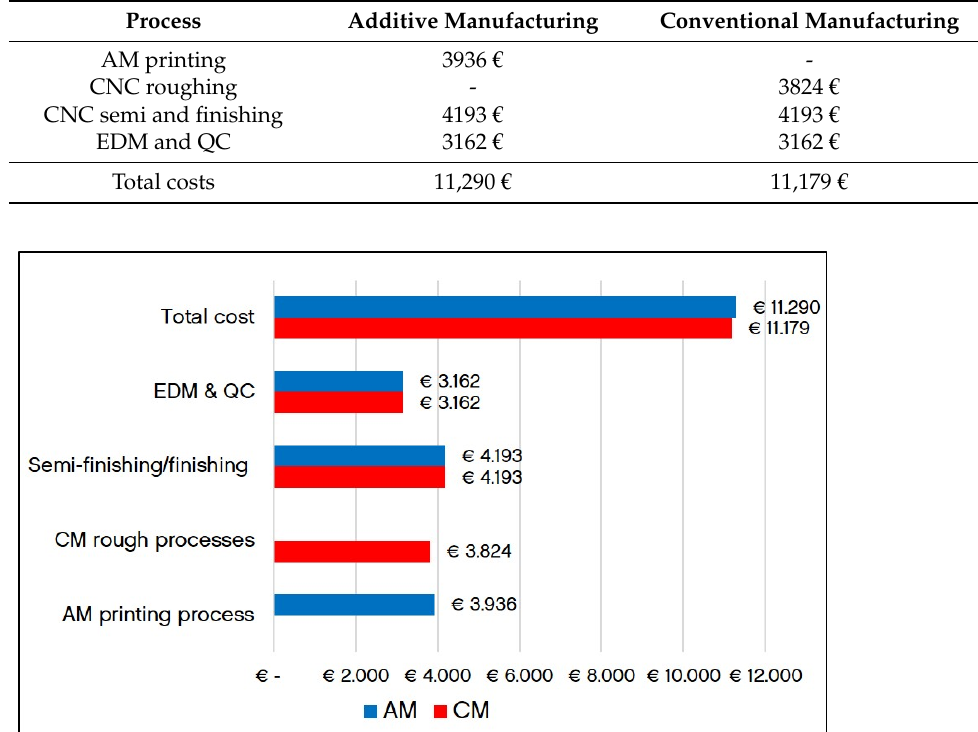
Figure 10. Total AM and CM cost comparison (each set of tools used for two inserts).